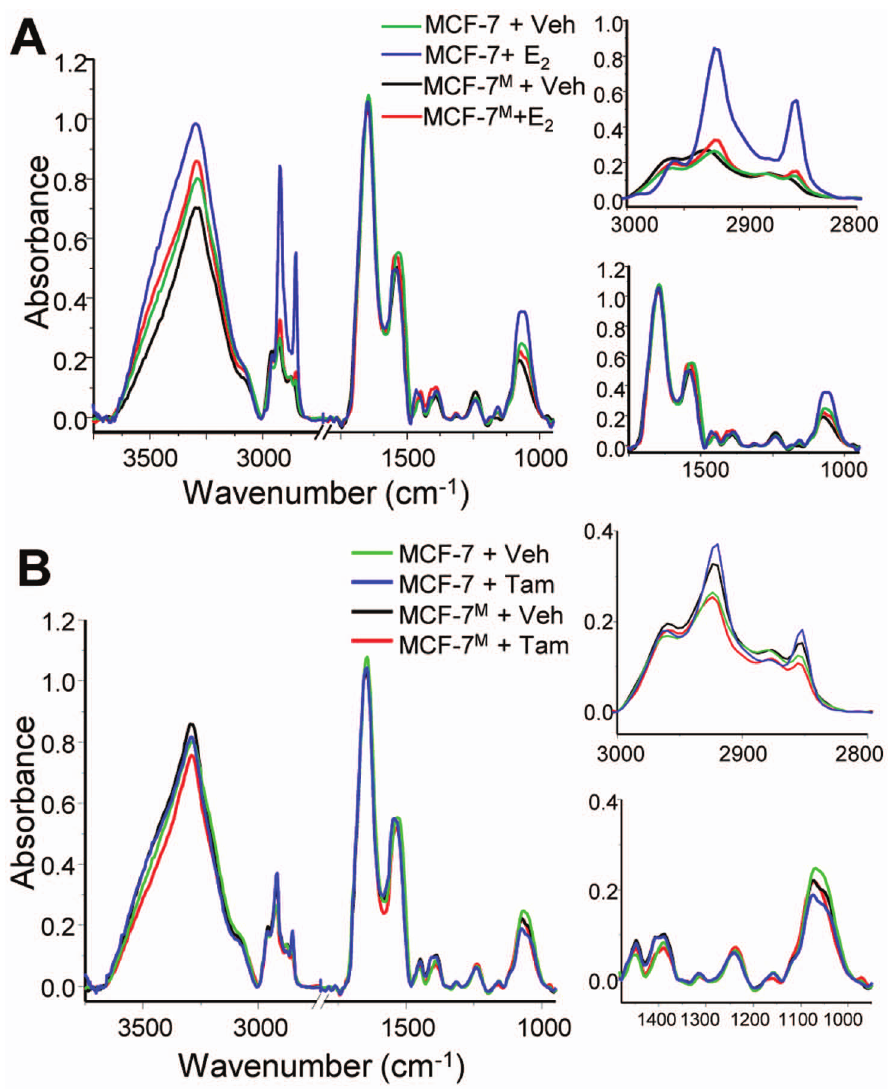
Figure 6. Fourier transform-infrared (FT-IR) spectroscopic imaging can be used to monitor hormone response in cells in culture. (A) A change in FT-IR spectroscopic imaging is seen in MCF-7 cells treated with estradiol (E 2 ), particularly in the C-H stretching region (3000 – 2750 cm 2 1 ) and in the peak associated with nucleic acids (1080 cm 2 1 ). However, when cells are co-cultured with human mammary fibroblasts (HMF), the response to hormone is lost. (B) Spectral changes are also seen in MCF-7 cells treated with tamoxifen (Tam). While there is a slight induction in peaks associated with the C-H stretching region upon treatment with Tam, the peak associated with nucleic acids, and therefore proliferation, is decreased in MCF-7 cells. This is correlated with the anti-proliferative effects of tamoxifen on ER + cells. In samples that have been co-cultured with HMF, this change is not seen at the 1080 cm 2 1 peak, corresponding to the endocrine-resistant growth that was seen using proliferation assays.